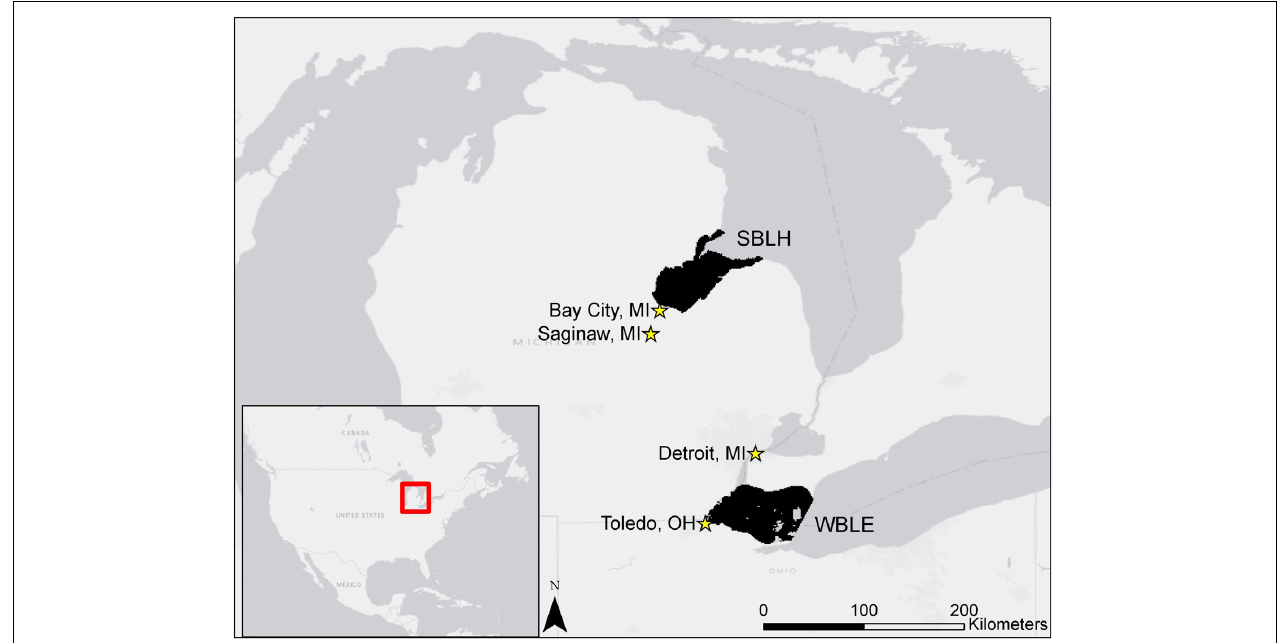
FIGURE 1 | Regions studied for impacts related to the coronavirus (COVID-19) pandemic. The western basin of Lake Erie (WBLE) and Saginaw Bay in Lake Huron (SBLH) are heavily impacted by anthropogenic factors. The major population centers around each basin are also shown, including Toledo, Ohio and Detroit, Michigan (WBLE); and Bay City, Michigan and Saginaw, Michigan